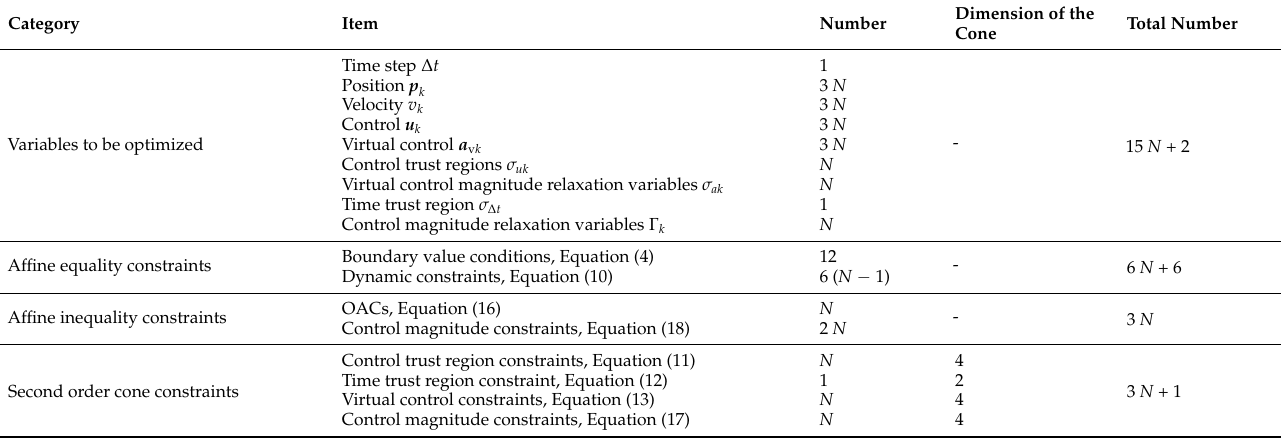
Table 1. Variables and constraints in Problem